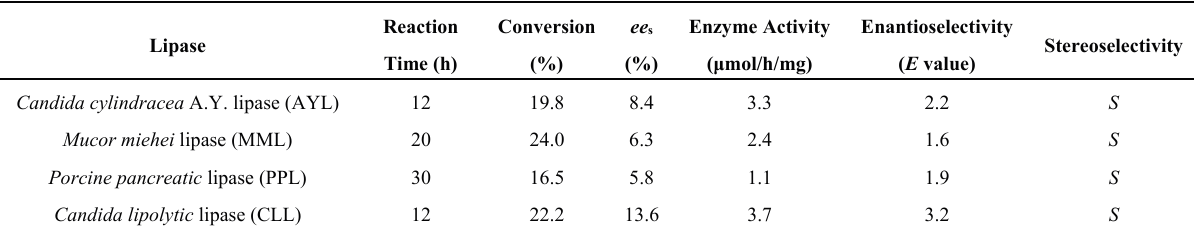
were performed at 30 °C and 150 rpm.